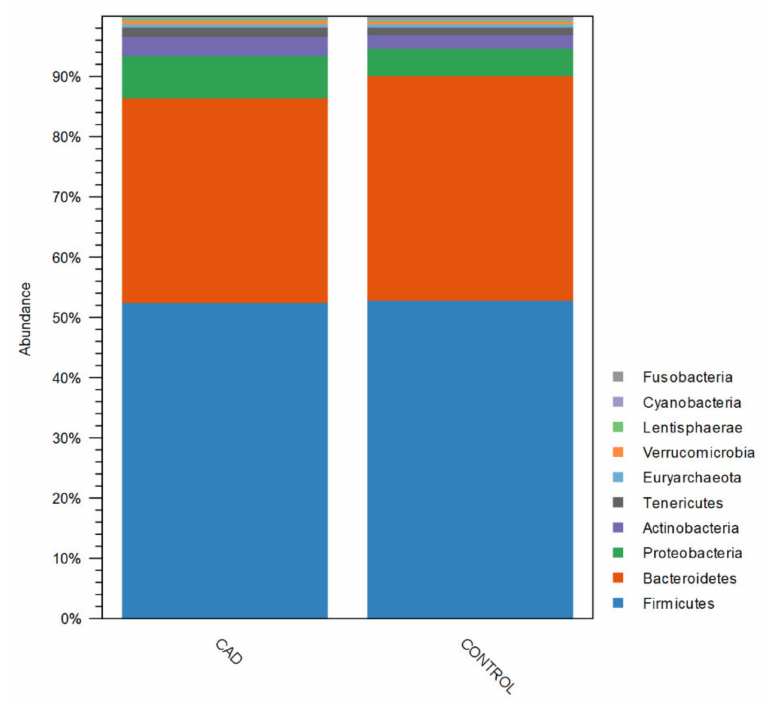
Figure 2. Composition of bacteria phyla in studied populations. CAD—coronary artery disease group.